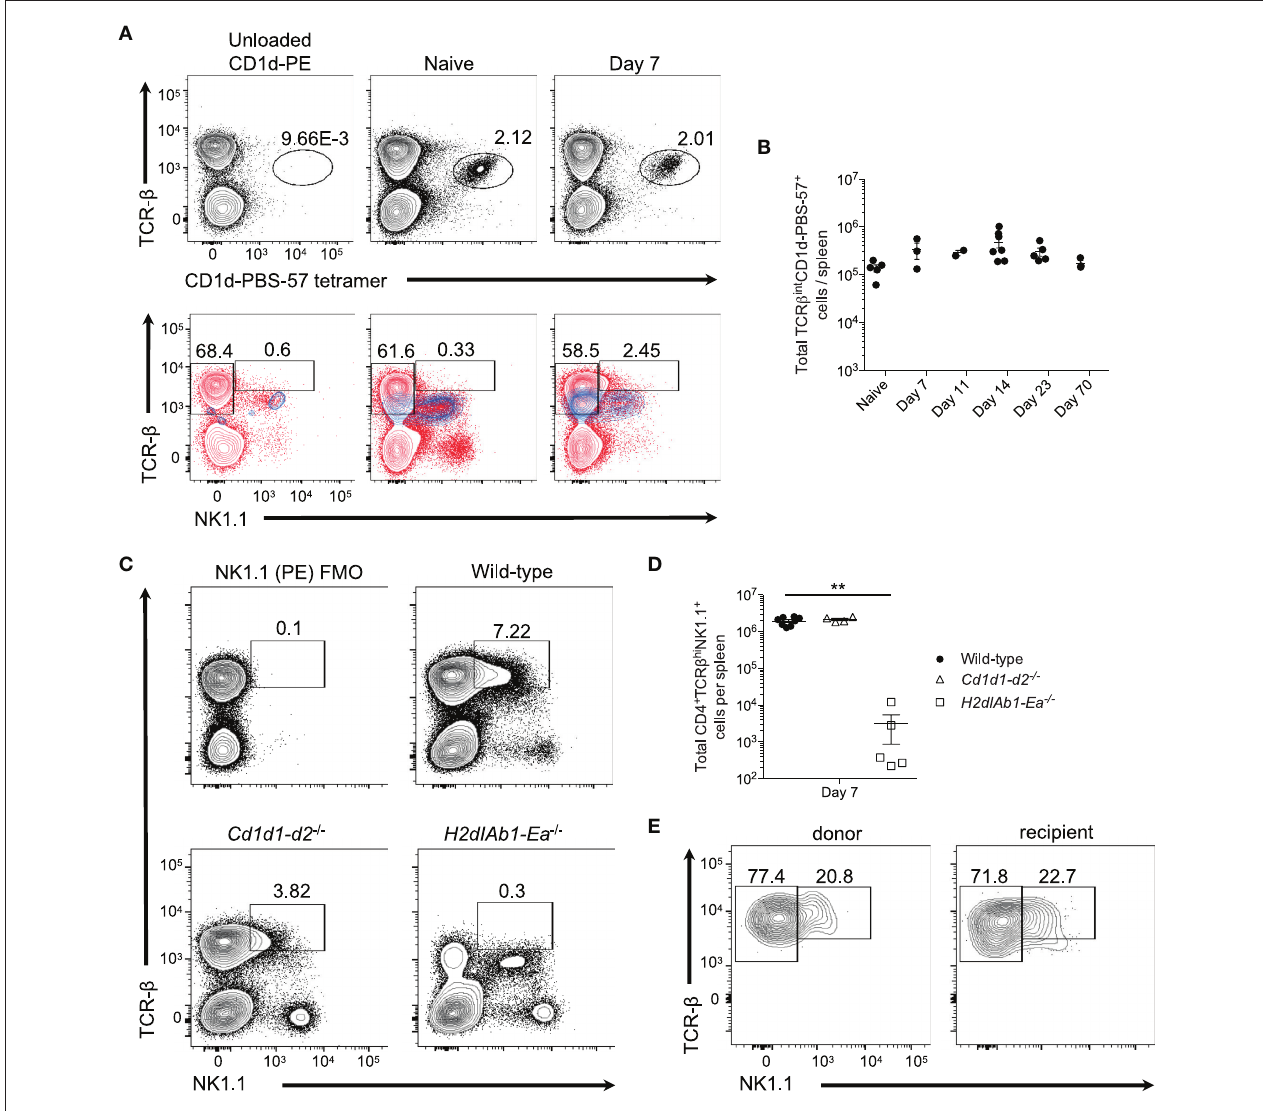
FIGURE 2 | Type I invariant NK-T cells do not expand during P. yoelii infection. (A) Top: Representative TCR β and PBS-57 tetramer staining in naive and day 7 post- P. yoelii infected mice. Unloaded CD1d tetramer, negative staining control. Bottom: Representative TCR β and NK1.1 expression (blue contour plots) on unloaded CD1d tetramer + cells (left), or CD1d-PBS-57 tetramer + cells from naïve (middle) and day 7 infected mice (right). Red contour plots represent TCR β and NK1.1 expression on total splenocytes. Cells previously gated on live, dump- splenocytes. (B) Total number of live TCR β int CD1d-PBS57 + type I NK-T cells per spleen. Data are representative of two independent experiments (error bars, s.e.m.). (C) Representative TCR β and NK1.1 expression at day 7 post- P. yoelii infection in wild-type, CD1d deficient ( Cd1d1-d2 − / − ), or MHC-II deficient ( H2dIAb1-Ea − / − ) mice. FMO, fluorescence minus one staining control. (D) Total number of live CD4 + TCR β + NK1.1 + T cells per spleen at day 7 post-infection. Significance calculated by one-way ANOVA Kruskal-Wallis test with post hoc Dunn’s multiple comparisons test. ** p < 0.01. (E) Representative TCR β and NK1.1 expression on endogenous CD45.1 + or donor CD45.2 + CD4 + T cells at day 8 post-infection. Naïve (CD44 lo CD62L hi ) CD4 + T cells from C57BL/6 mice (CD45.2 + ) were sorted and transferred i.v. into congenic CD45.1 + mice 1 day before challenge with P. yoelii . Data are representative of two independent experiments (error bars,